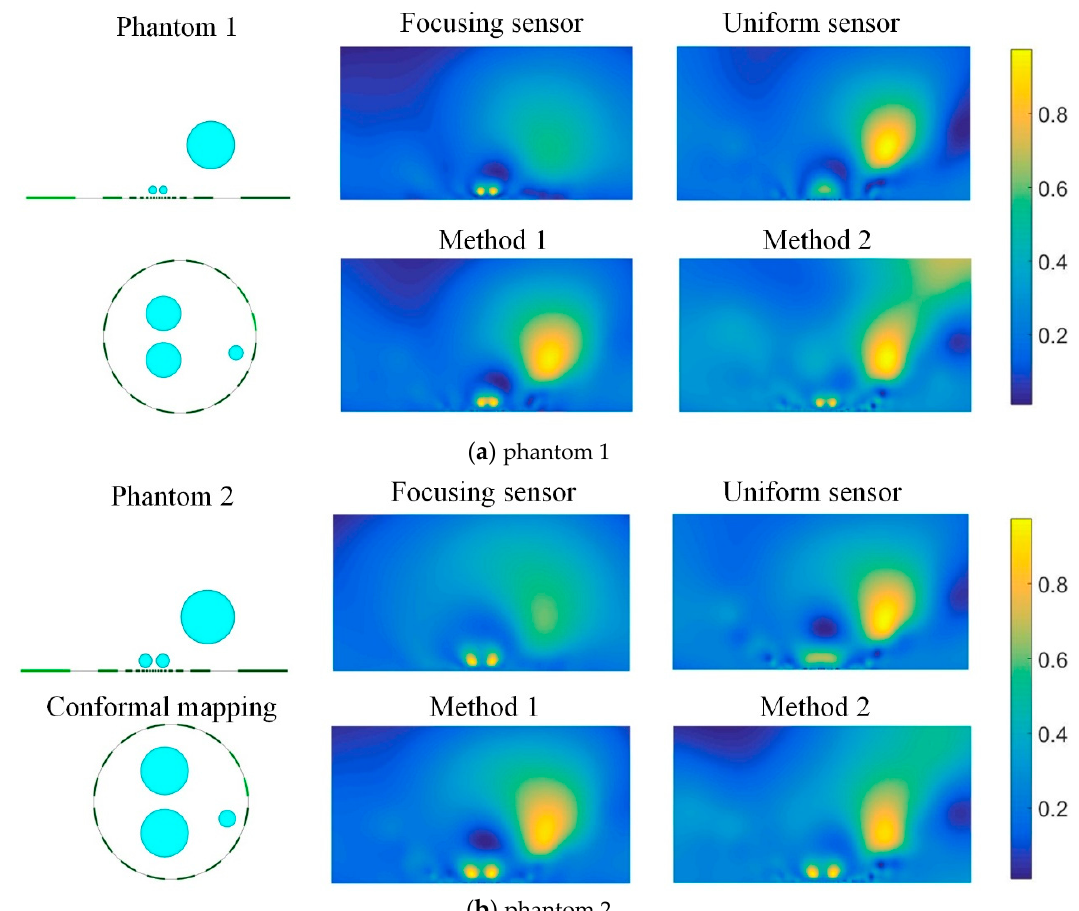
Figure 14. Reconstructed results of two different phantoms from focusing sensor, uniform sensor, and two fusion methods.